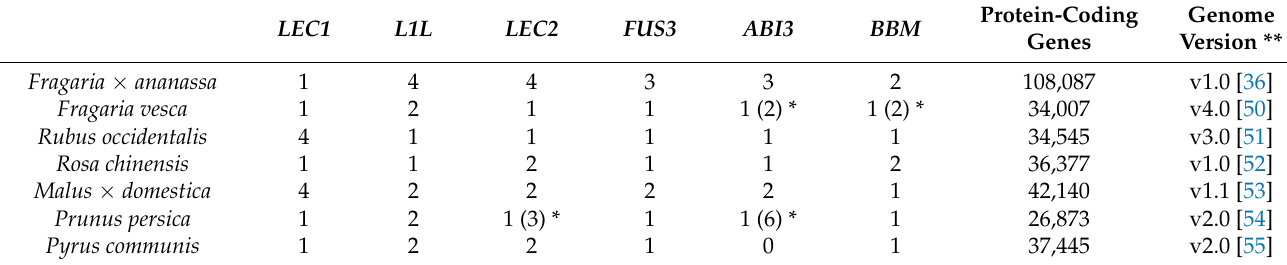
Table 2. Loci and allele number of somatic embryogenesis-related transcription factors identified in Rosaceae